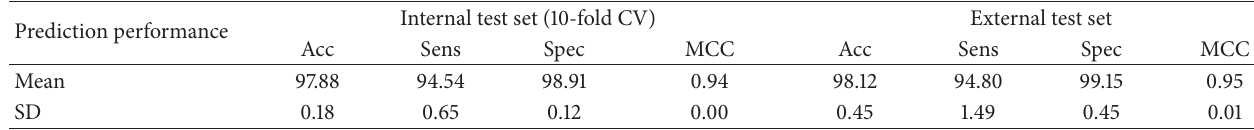
Table 4: Summary of prediction performance for MS classification using Random Forest from 20 independent runs.